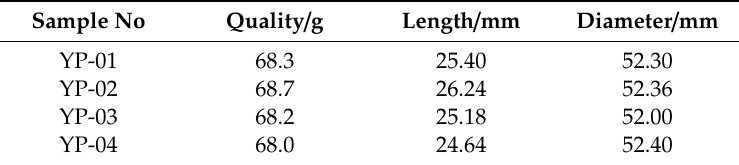
Table 3. Parameters of disc-type briquette samples.